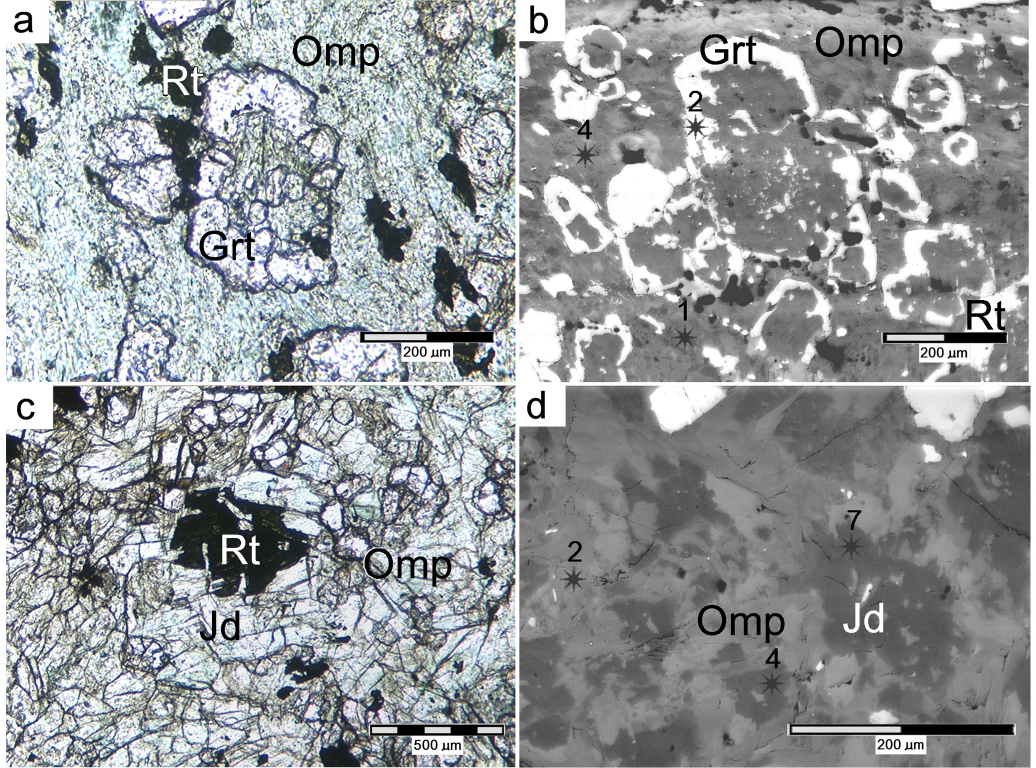
Figure 10. Photomicrographs of eclogite: (a, b) fractured garnet (Grt), with an atoll-like habit, forms aggregates included in a matrix consisting of mylonitic omphacite (Omp) and occasionally contoured by (brown) rutile (Rt) (67142/8936, PPL; 3088, SEM image, BSE), the numbered stars indicate the spots in which EDS analyses were collected (see Table S13 for pyroxenes, i.e., analytical spots nos. 1 and 4, and S14 for garnet, i.e., analytical spot no. 2). (c) An admixture of sub-millimetric, idioblastic crystals of jadeitic (light green; Jd) and omphacitic (dark green; Omp) pyroxenes, with scarce garnet. In the middle there is a large rutile aggregate (Rt) (7144, PPL). (d) Restricted jadeite domains (darker) with a relict appearance, including small blebs of exsolved omphacite, are surrounded and crossed by an omphacitic matrix, showing a complex zoning (enhanced by the various shades of grey) (7144, SEM image,